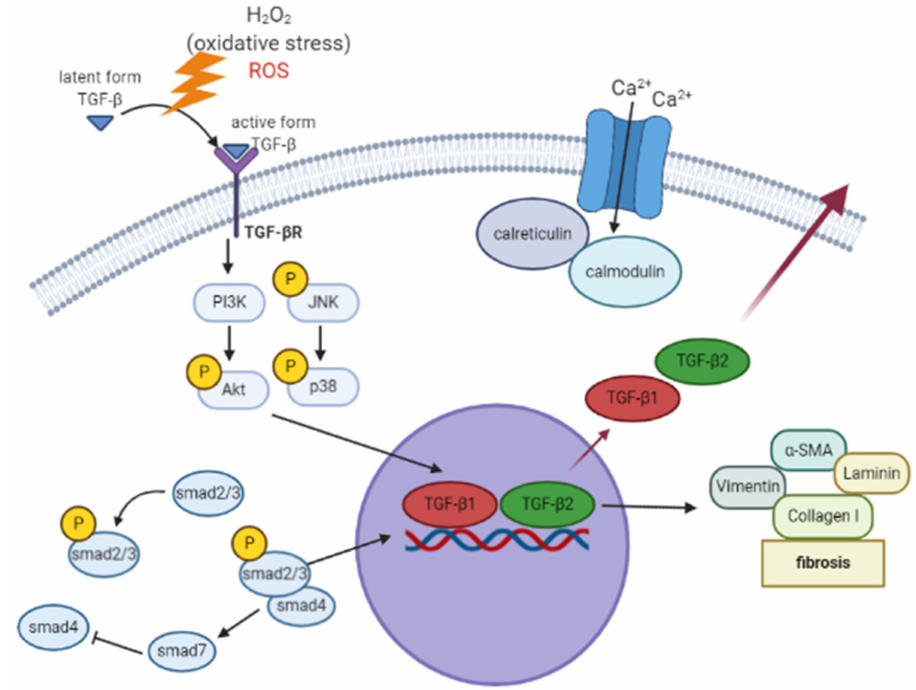
Figure 11. TGF- β -related oxidative stress signaling pathway in HTMCs (created in